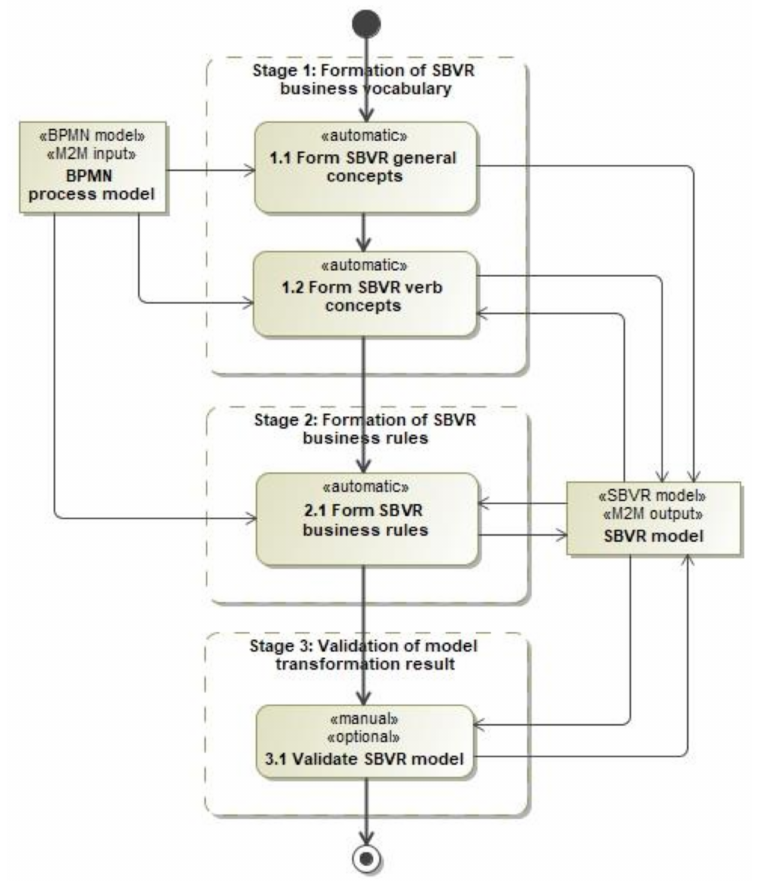
Figure 1. The overall architecture supporting the developed model transformation